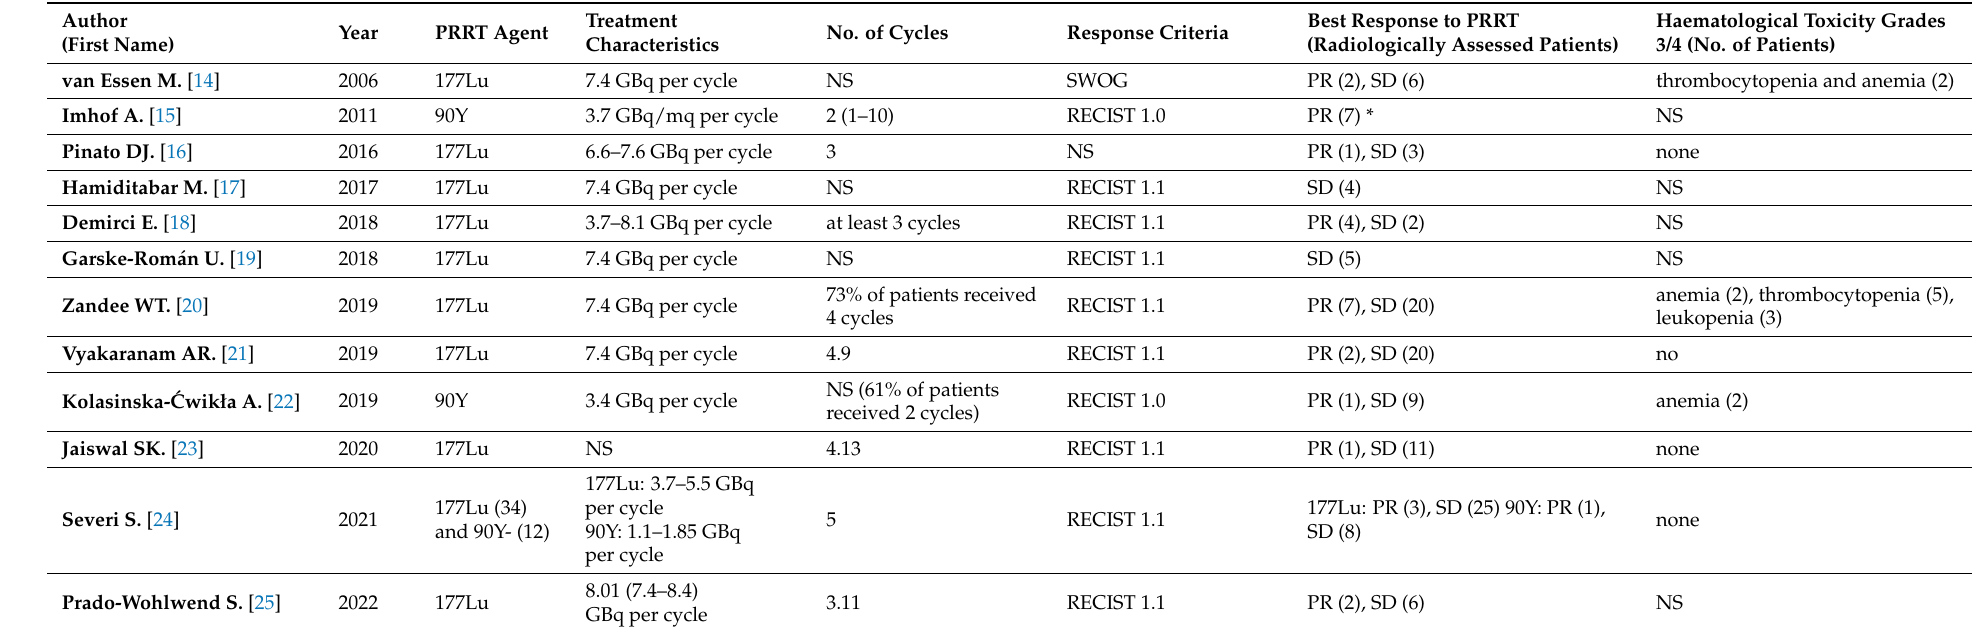
Table 2. Efficacy and toxicity profile of PRRT in the included